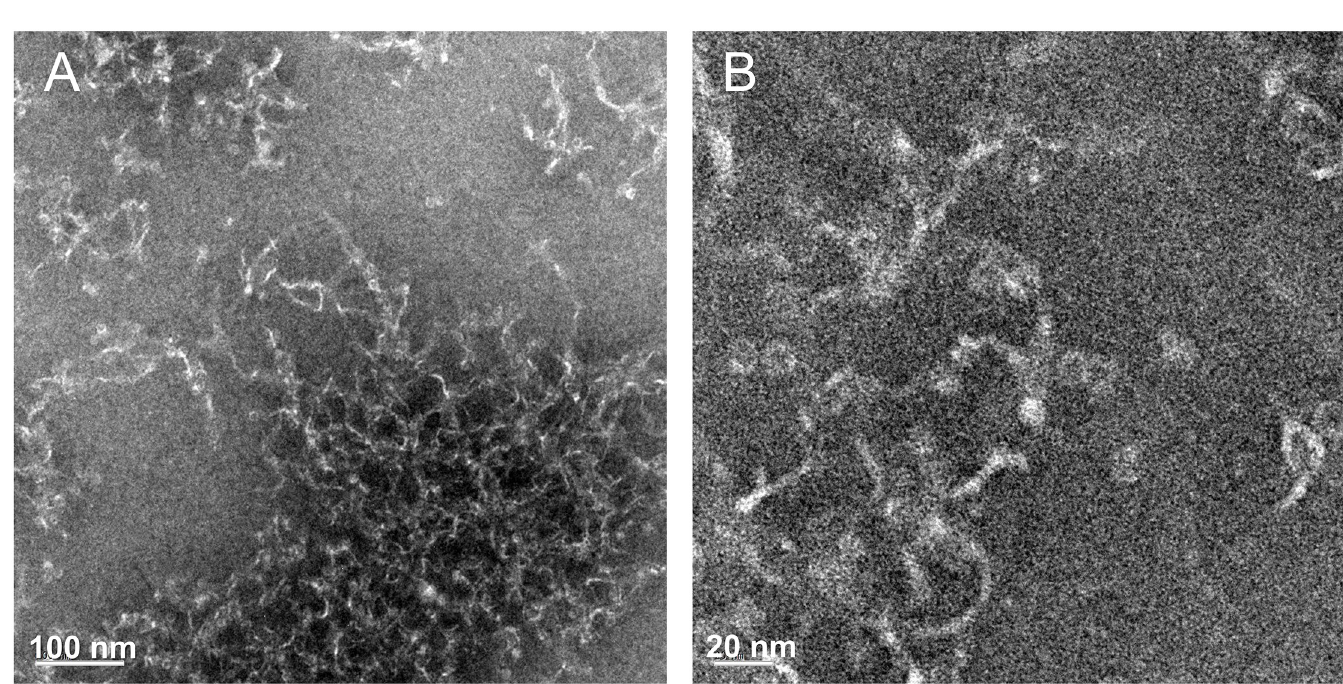
Fig 7. Negative-stain TEM images of apoferritin hydrogel. (A) Low and (B high resolution.